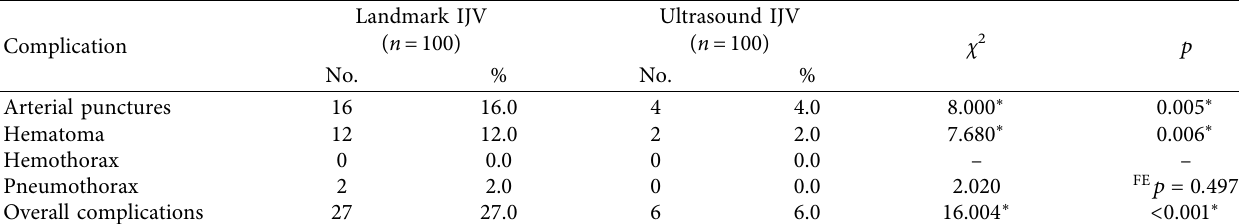
Table 3: Comparison between landmark and ultrasound techniques in IJV group (A) according to complications. Complication